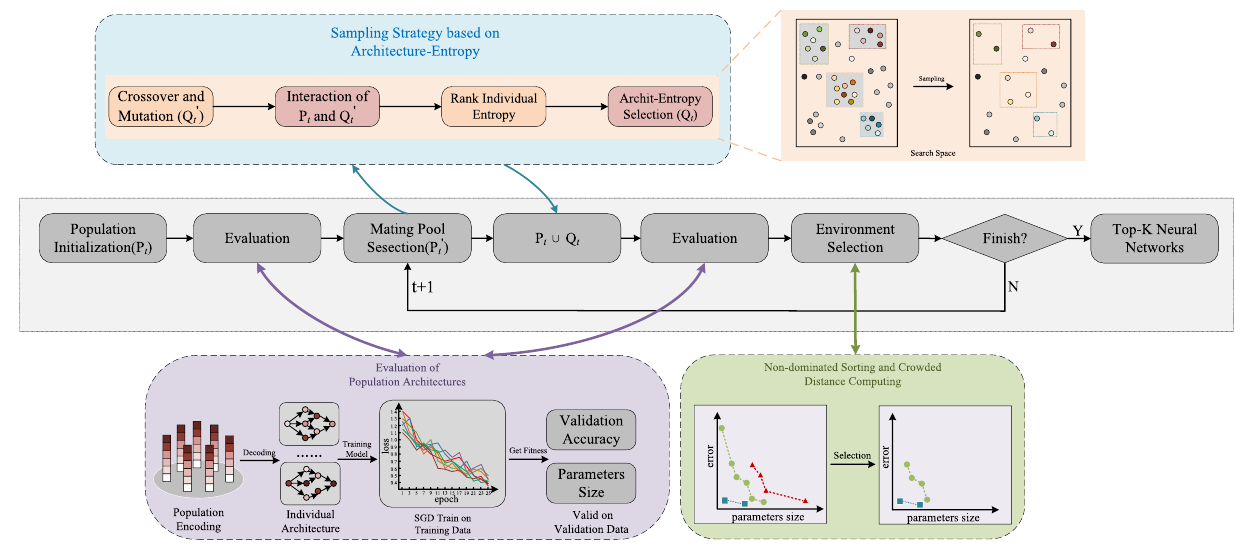
Fig. 3 The overall framework of the proposed AEMONAS